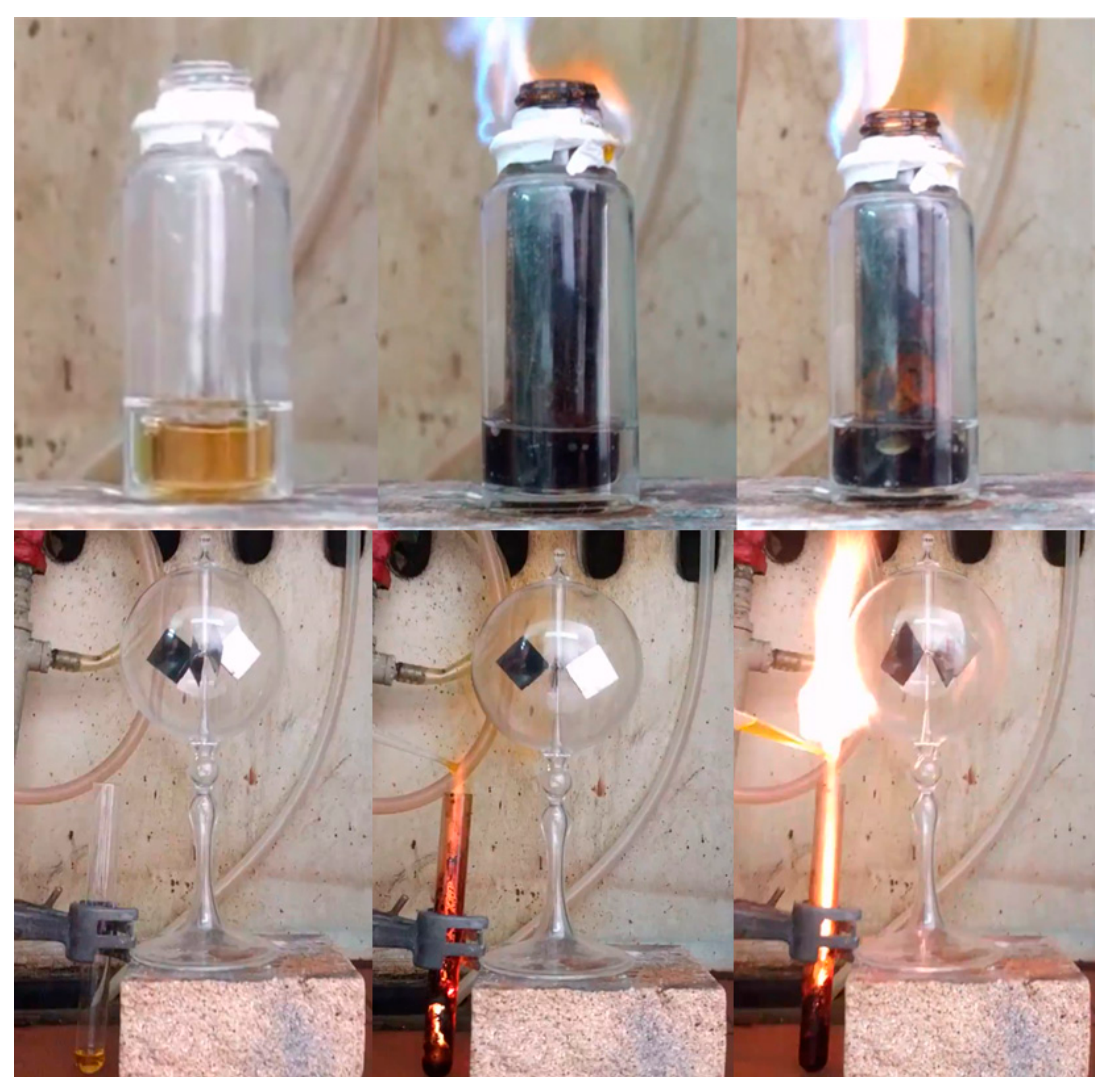
Figure 3. Top : A small glass vial filled with furfuryl alcohol was firmly fitted inside a bigger one containing acetone, as shown in the setup above. Acetone in the outer vial did not come into direct contact with the furfuryl alcohol in the inner vial. Teflon tape was placed at the contact of the fitted vials near the top rim in order to prevent flammable acetone vapor from escaping. The hypergolic reaction between furfuryl alcohol and fuming nitric acid released enough heat to boil acetone (boiling point 56 °C). The middle photo shows small bubbles that grew larger upon gradual heating of acetone to boiling (right photo). Bottom : A Crookes radiometer, initially at rest, was placed into motion by the released heat (e.g., notice how the polished side of the depicted vane changed position upon rotation). Spinning was relatively slow due to non-uniform heating of the